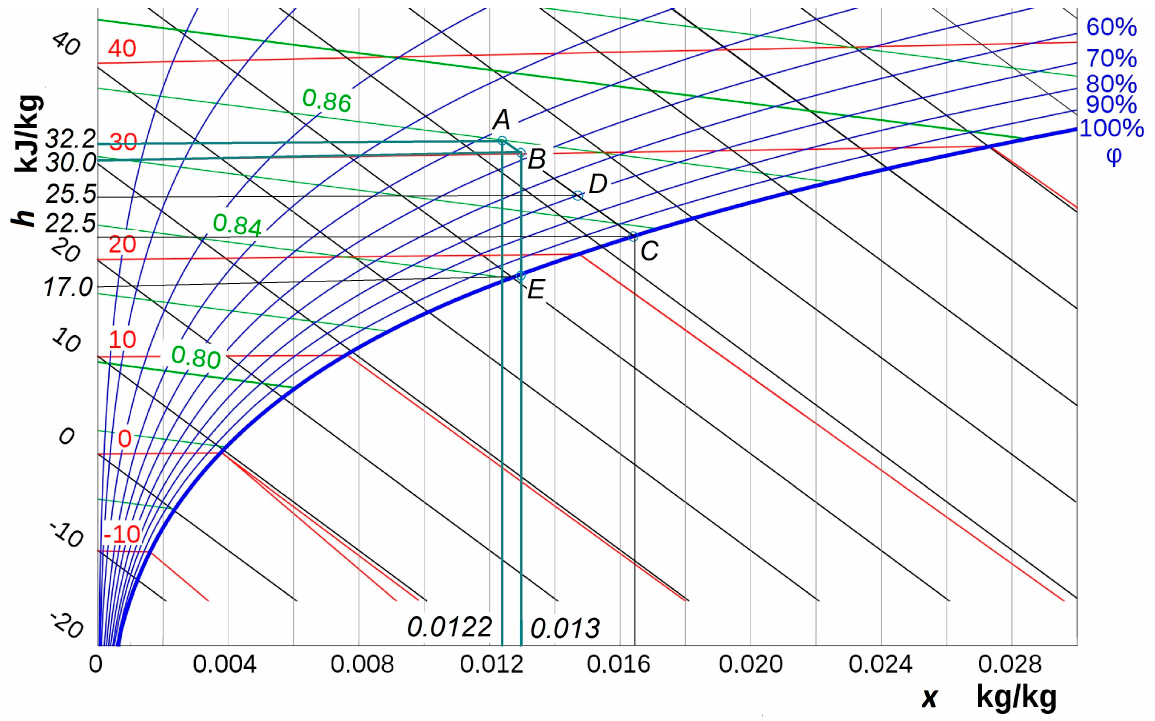
Figure 14. Fragment of Mollier ( h-x ) diagram. At moderate temperature values in the cowshed, for example the point at 17 working hours (Figures 8 and 9), the temperature ( T 1 ) and relative humidity ( RH 1 ) for the air coming from outside were 21.0 ◦ C and 81.6%, respectively. Due to the operation of the cooling system, the temperature ( T 2 ) of the air in the cowshed decreased to 19.9 ◦ C, and the humidity ( RH 2 ) increased to 83.9%. The coefficient c of air saturation was 0.55. The wet-bulb temperature ( T W ) was 19 ◦ C. However, the operation of a cooling system in